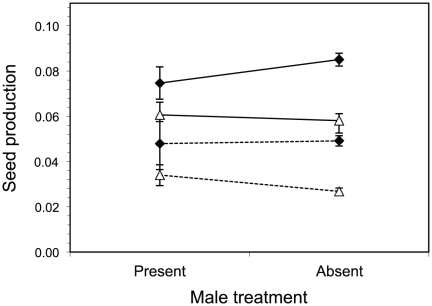
Differences in the proportion of above-ground biomass allocated to seeds between females (σf - diamonds) and hermaphrodites (σh - triangles) in plots with and without males.Means (± S.E.) of plants grown under high densities are joined with a solid line, and with a dashed line for plants grown under low densities.